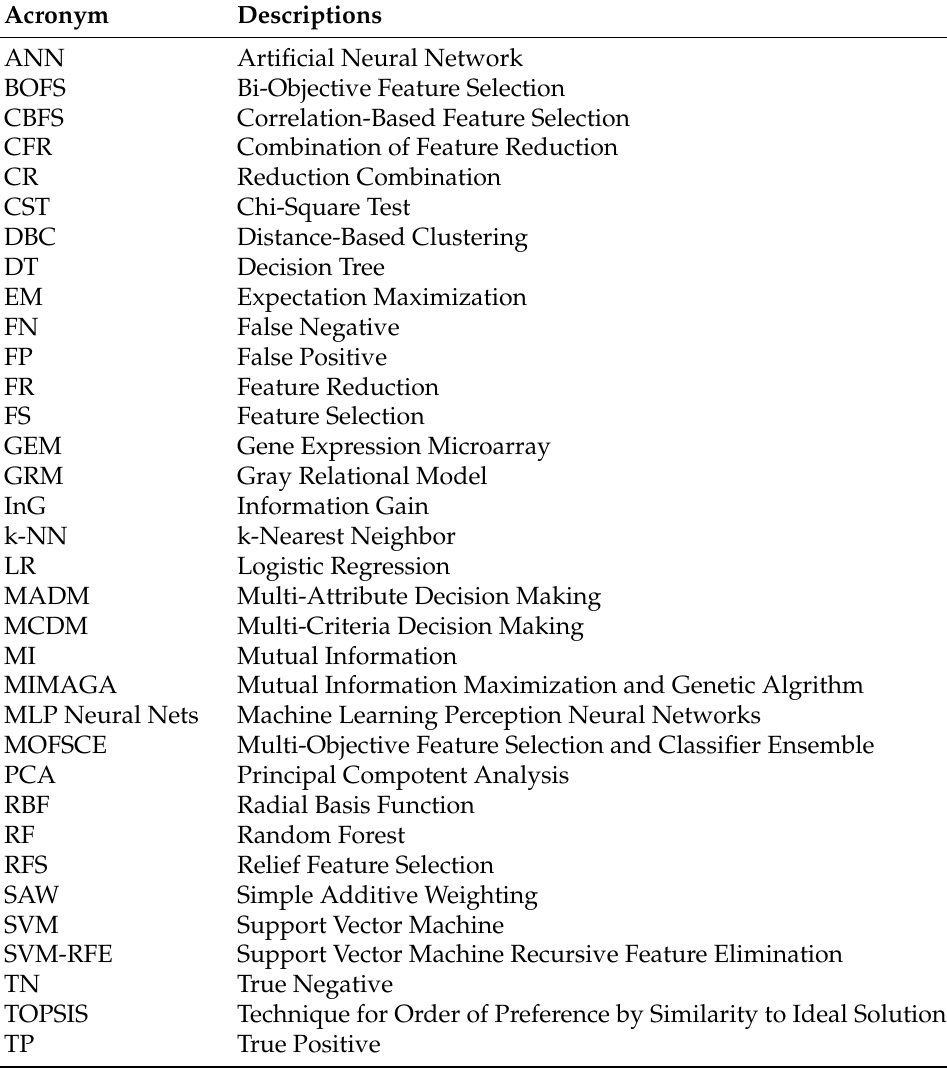
Table 1. Acronym and